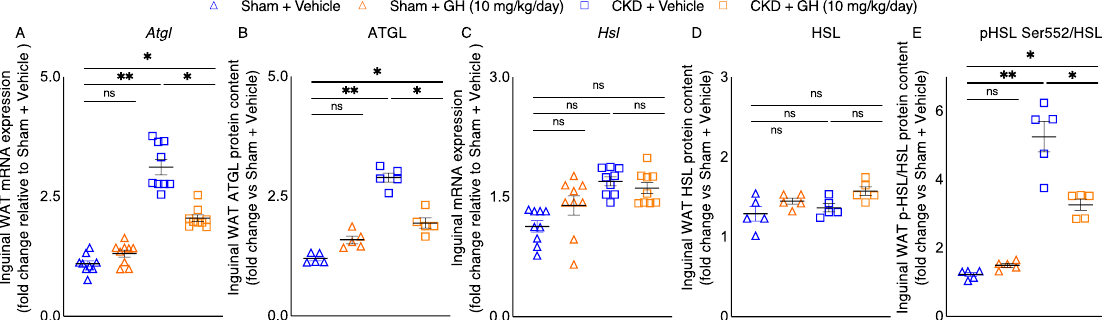
Figure 3. Lipolytic gene expression and protein content in CKD mice. CKD mice were fed ad libitum, whereas other mouse groups received an energy intake amount equal to that of CKD + Vehicle mice.